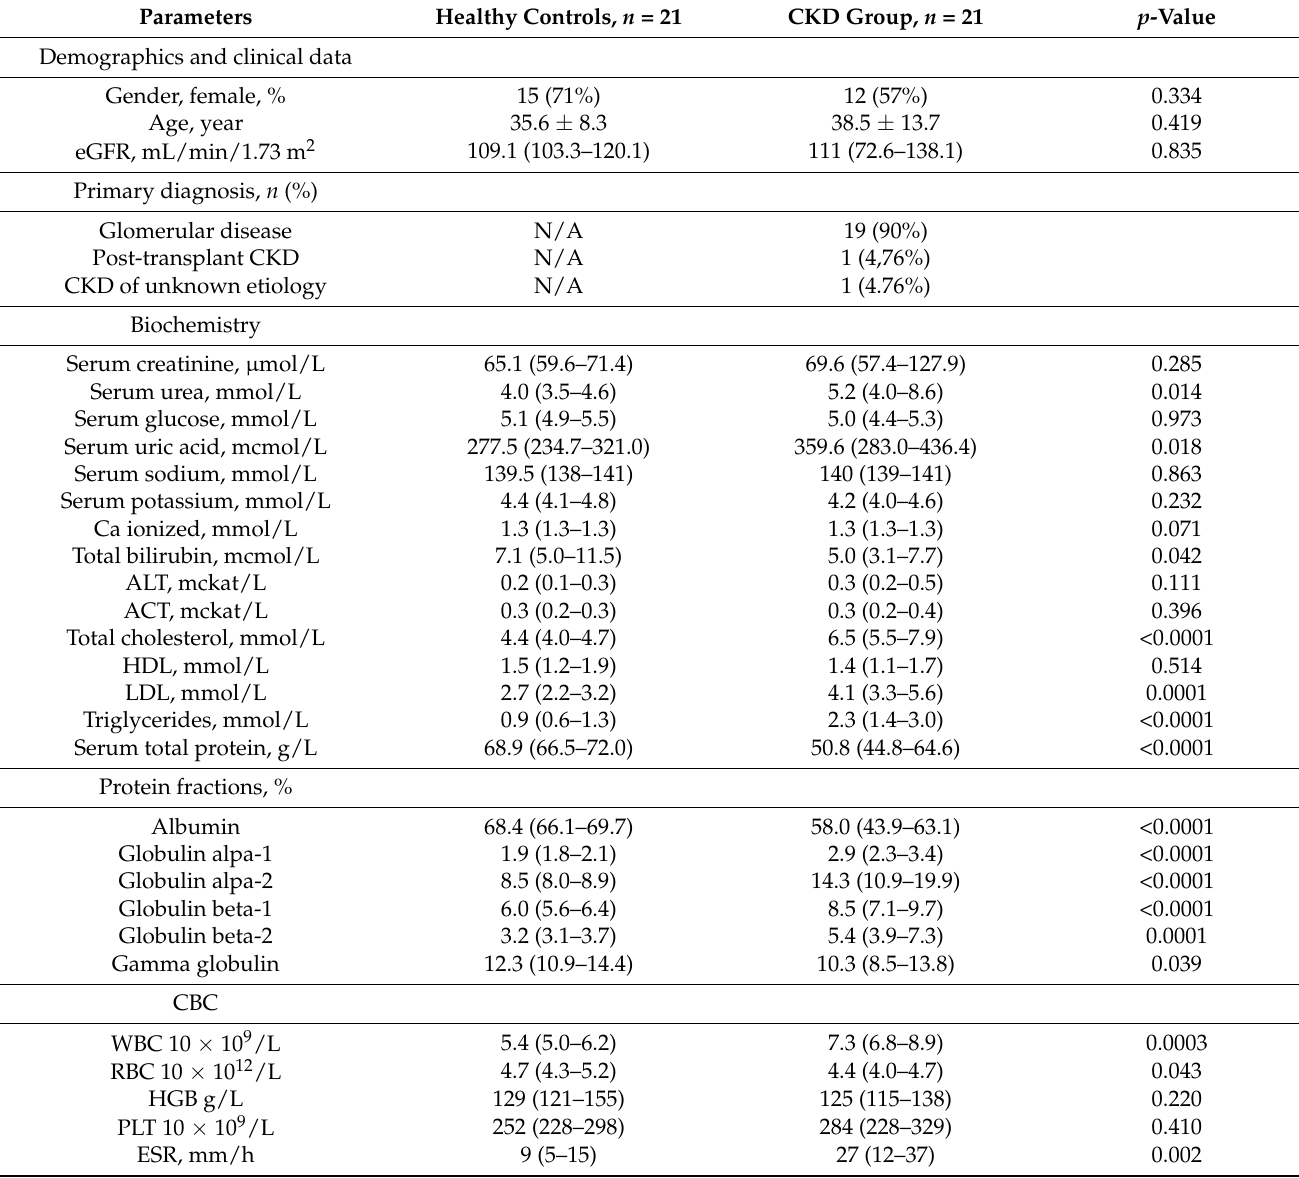
Table 1. General and clinical biochemical characteristics of